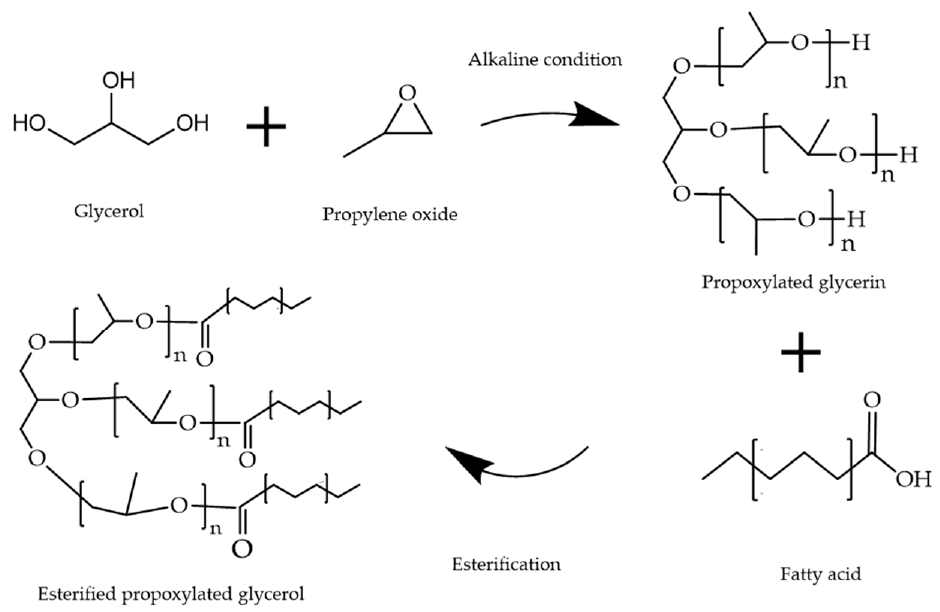
Figure 4. The systhesis mechanism of esterified propoxylated glycerol (EPG).